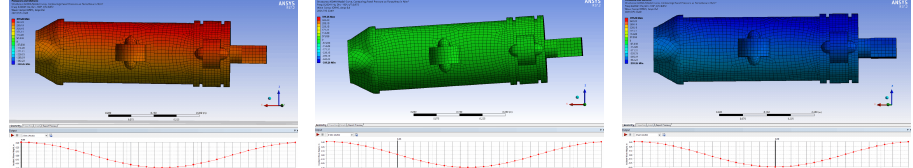
Figure 16. Surface pressure nephogram of the Shark-AUV at different location of the wave, from left to right: crest, balance state, and trough.